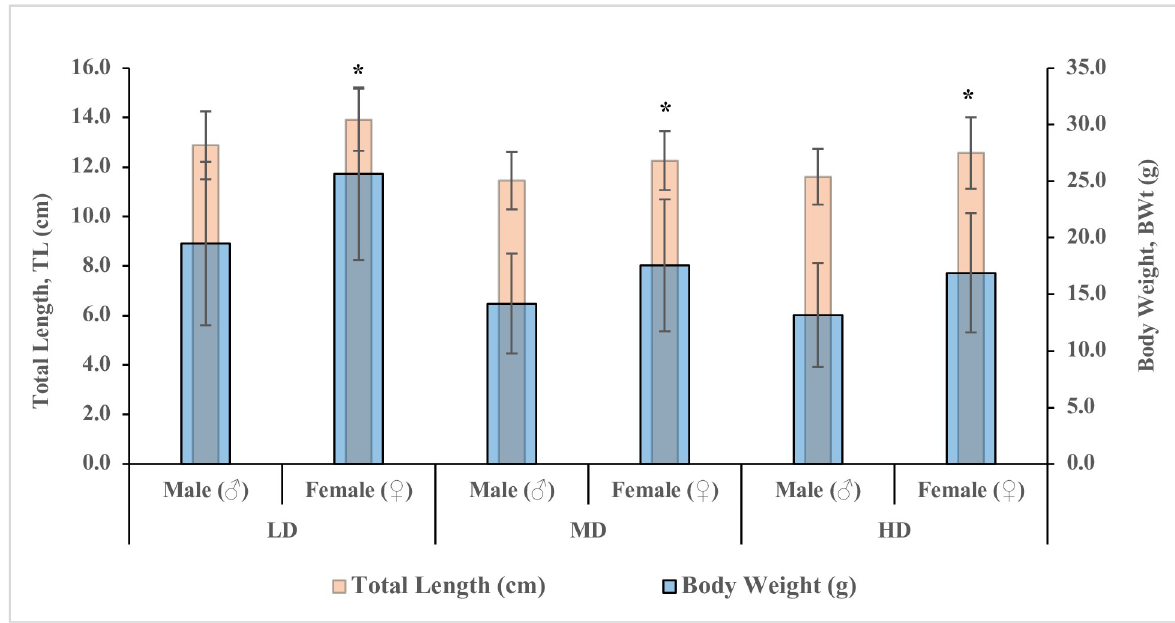
Fig 1. The final total length (cm) and body weight (g) of juvenile male and female yellow perch, Perca flavescens , reared at different stocking densities. The data represent the mean ± SD. The mean values within the same group with an asterisk are significantly higher ( P < 0 . 05 ).